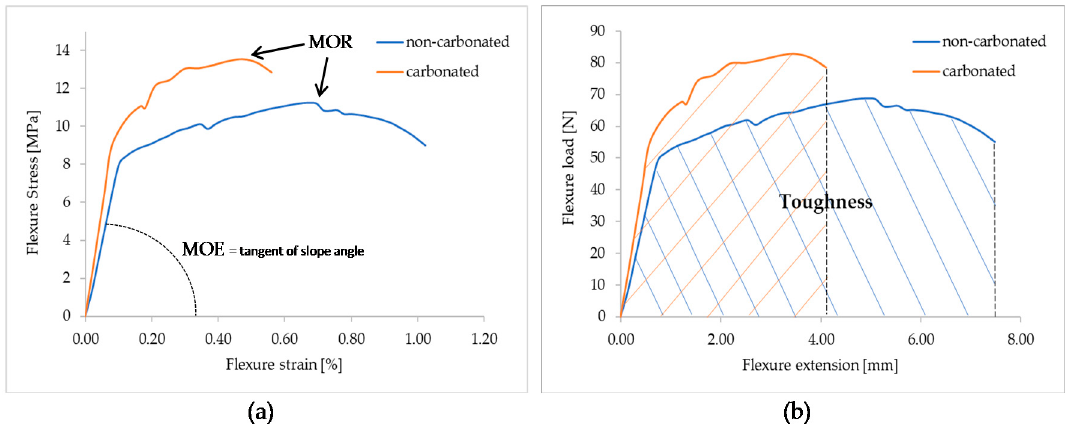
Figure 2. The flexural stress versus flexural strain/deflection curves to characterize the mechanical properties of the cement composite materials: ( a ) Modulus of rupture (MOR) and modulus of elasticity (MOE); ( b ) toughness.